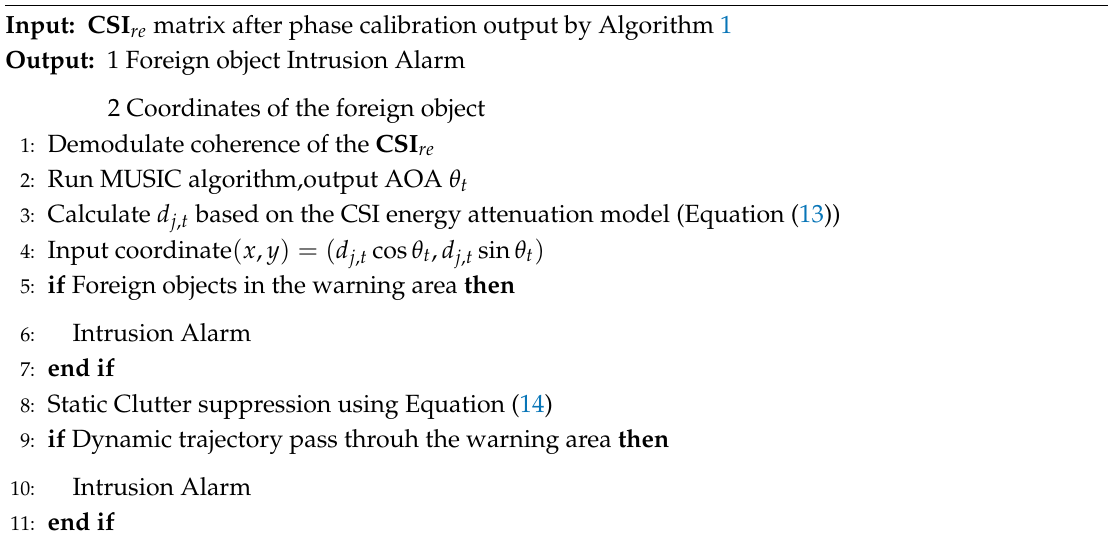
Algorithm 2 Foreign object detection and localization